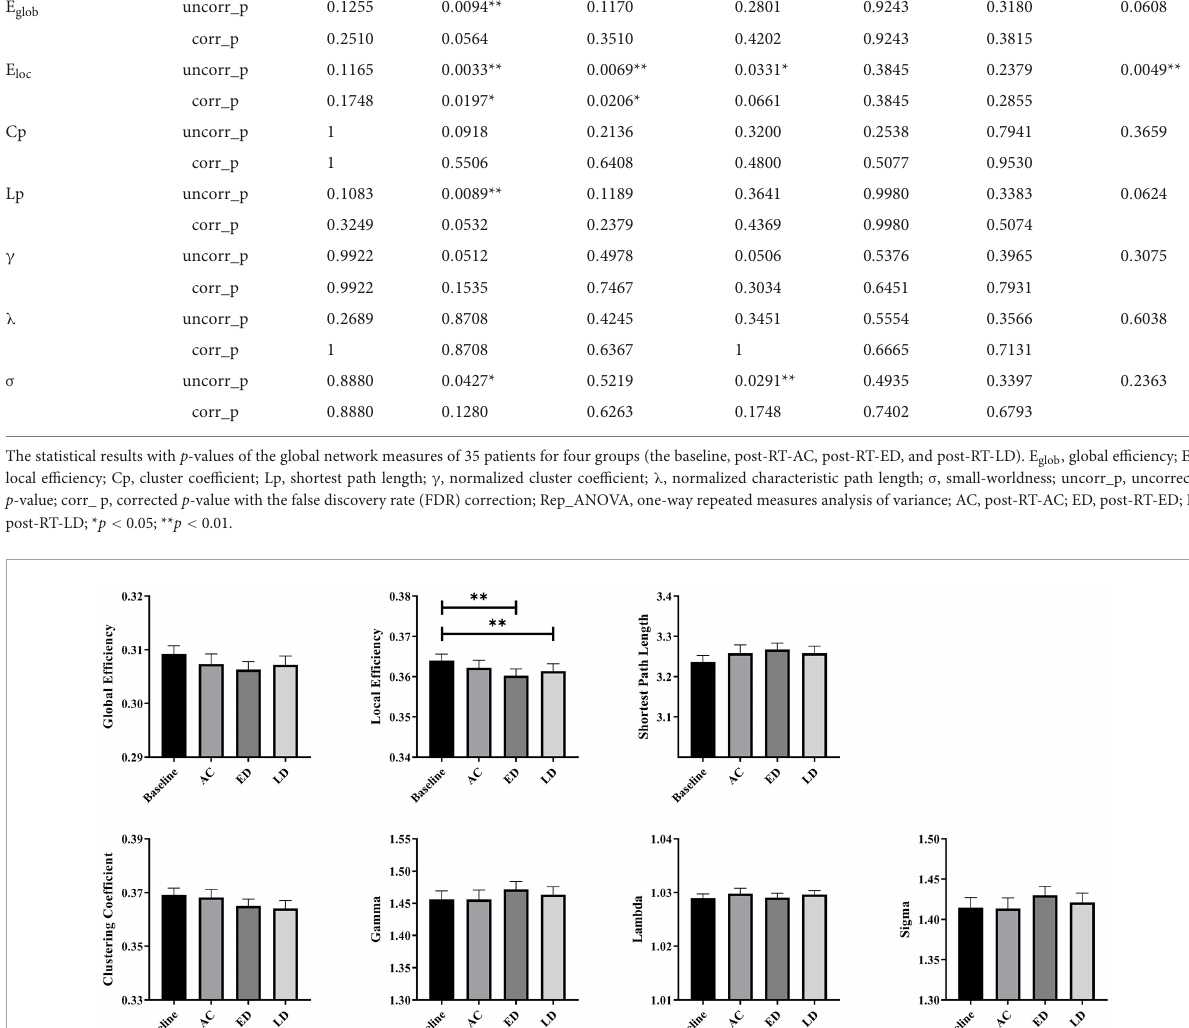
TABLE 1 The statistical results of the global network measures for four time stages. Global network measures